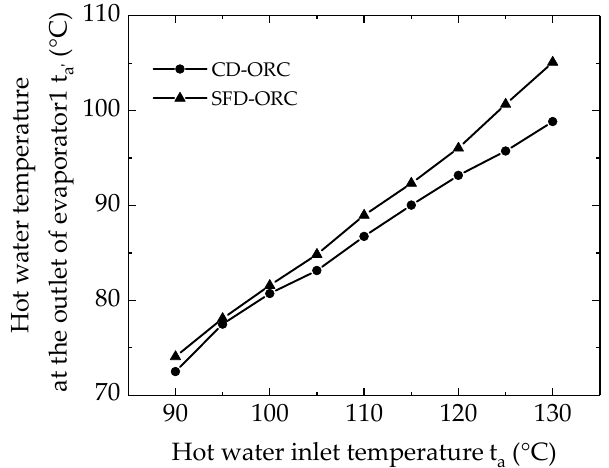
Figure 10. The optimal hot water outlet temperature.